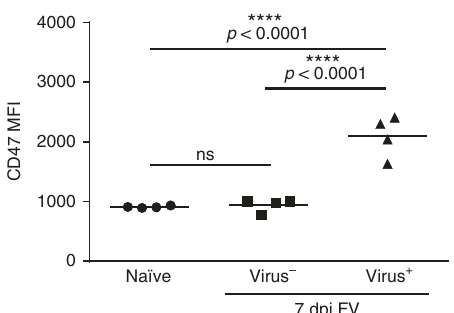
Fig. 7 Upregulation of CD47 on Friend virus (FV)-infected splenocytes. Mice were infected with FV or left naive and the splenocytes were analyzed by fl ow cytometry to compare the mean fl uorescence intensity of CD47 on naive or FV-infected (Virus + ) and uninfected (Virus − ) total splenocytes at 7 days post-infection (dpi) with signi fi cance as indicated by one-way analysis of variance. Virus was detected by cell surface expression of glycosylated gag antigen with mAb 34 as described in Methods. Data from one of four independent experiments are shown. ns, ****p ≤